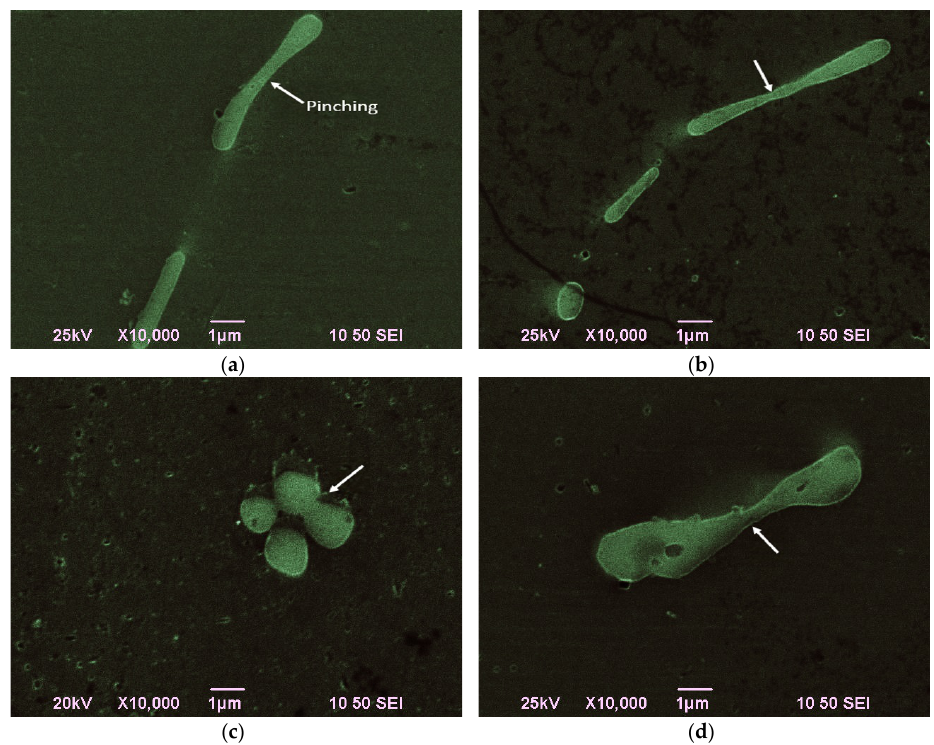
Figure 4. Images revealing the pinching process after 4 h holding time. ( a ) Local reduction of thickness; ( b ) pinching at advanced stage with seperation and local thickness reduction; ( c ) pinching in spherical particles; ( d ) local necking leading to pinching of a particle.